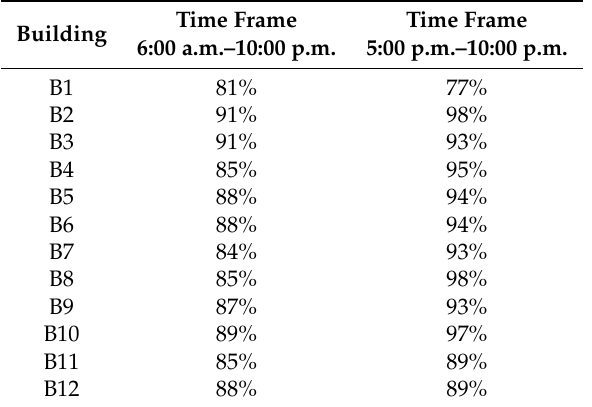
Table 7. Accuracy for each building: random forest classification model.